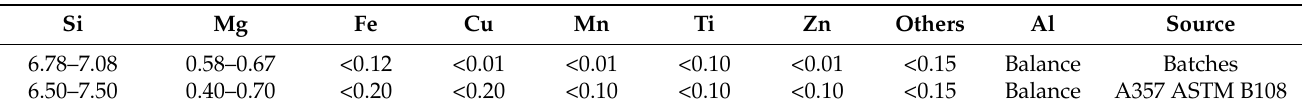
Table 1. Range of chemical composition in wt% of the AlSi7Mg batches used and of the A357 alloy ASTM B108 [33] requirements.